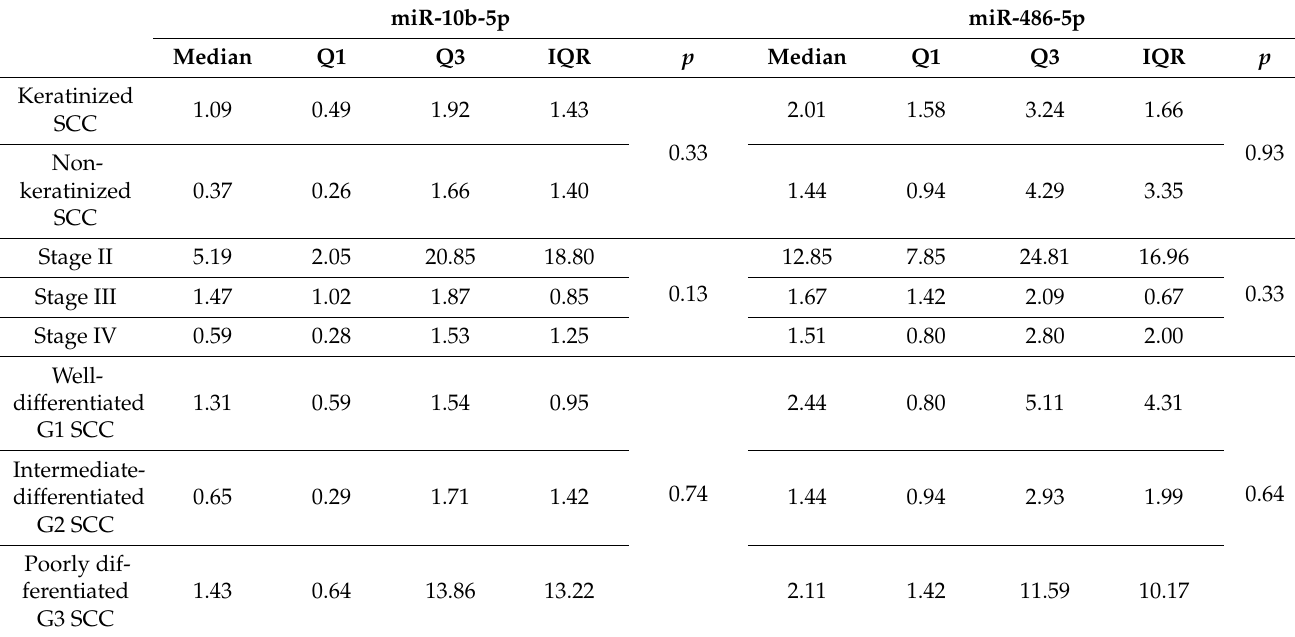
Table 2. miR ‐ 10b ‐ 5p and miR ‐ 486 ‐ 5p expression (Logarithm of relative fold changes). Table 2. miR-10b-5p and miR-486-5p expression (Logarithm of relative fold changes). miR-10b-5p miR-486-5p Median Q1 Q3 IQR p Median Q1 Q3 IQR